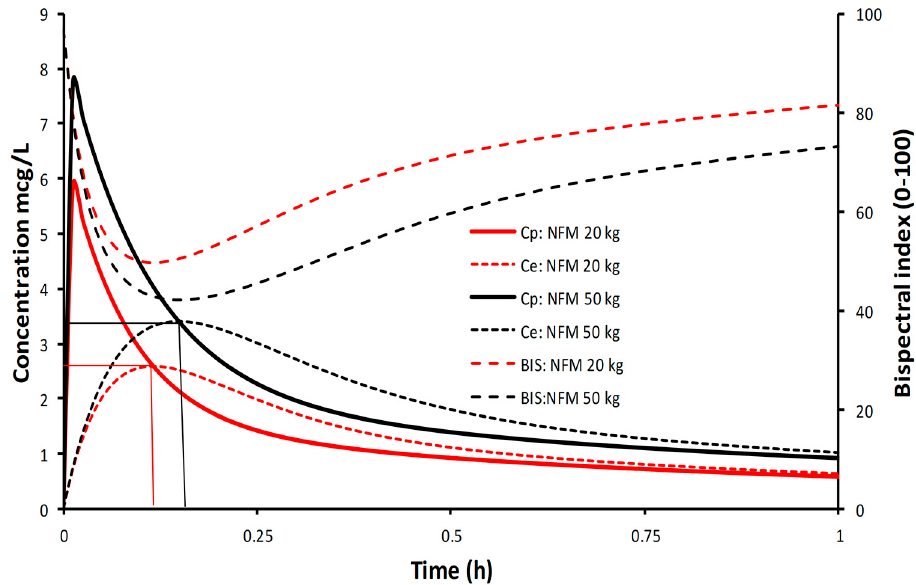
Figure 4. Estimation of volume of distribution at the time of peak effect (Vpe) in a 6 year old child of 20 kg and of 50 kg given dexmedetomidine 1 µg/kg [109]. Simulation performed using 20 kg and of 50 kg given dexmedetomidine 1 µ g/kg [109]. Simulation performed using dexmedetomi- dexmedetomidine pharmacokinetic parameters derived by Morse and colleagues [87]. dine pharmacokinetic parameters derived by Morse and colleagues [87]. Dexmedetomidine clearance Dexmedetomidine clearance was best scaled using FFM and NFM (FfatV = 0.29) for volume of was best scaled using FFM and NFM (FfatV = 0.29) for volume of distribution.